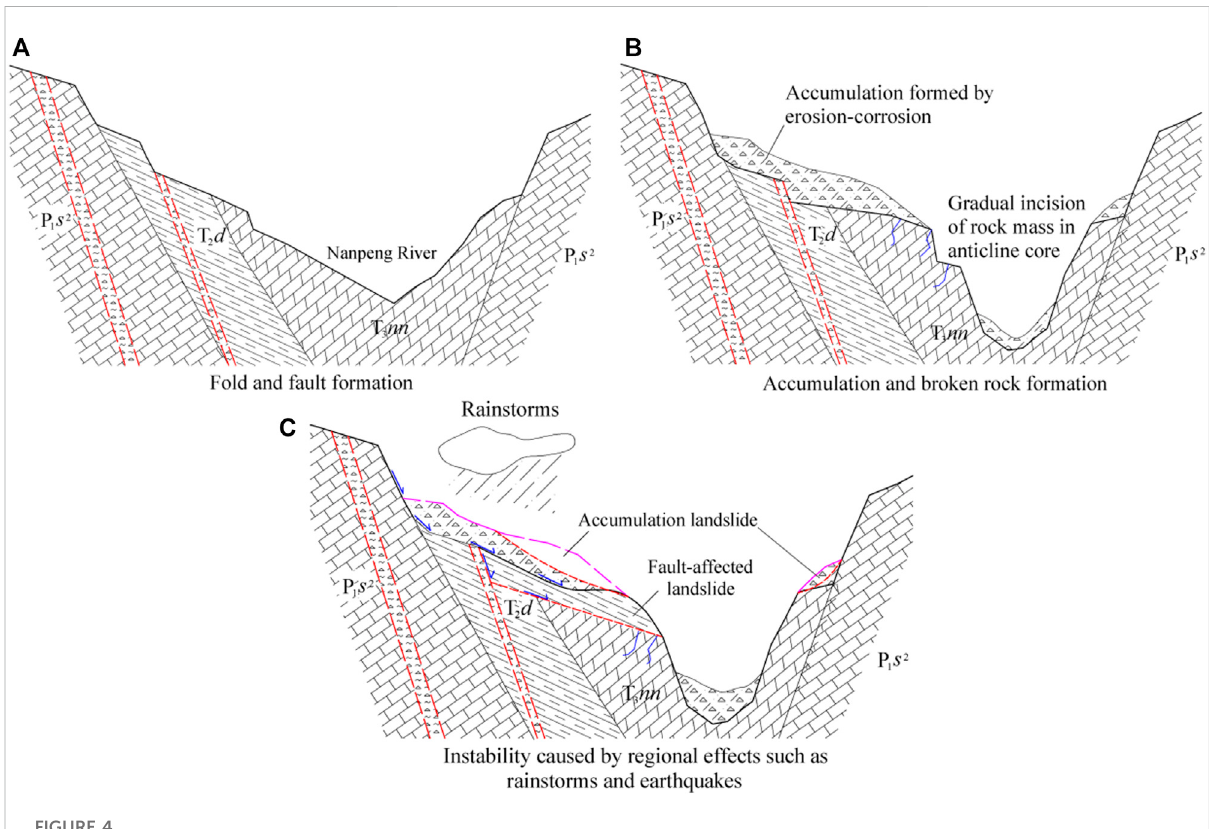
Front and landslide depression of the K33 + 800 fault-in fl uenced